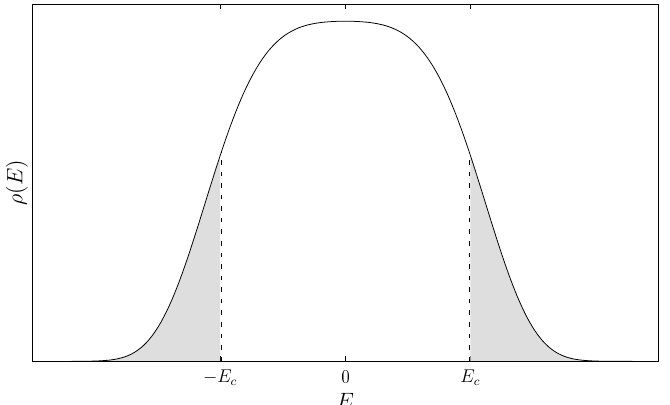
Figure 3. Sketch of the density of states ρ (see Equation (9)) as a function of energy E in the Anderson model, Equation (3). Localized modes are present in the shaded region beyond the E c mobility edges ±